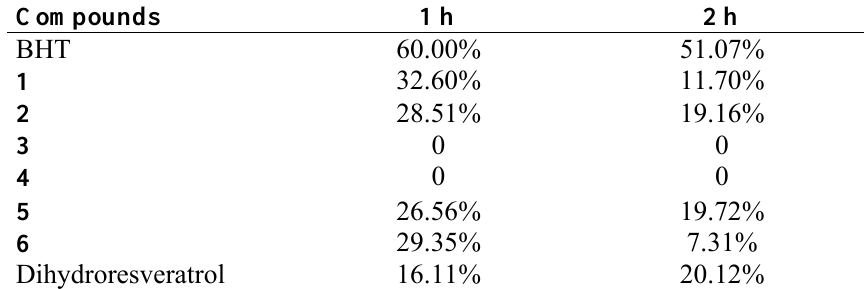
Table 4. Linoleic acid autoxidation inhibition of compounds 1 - 6 of N. nivea . a